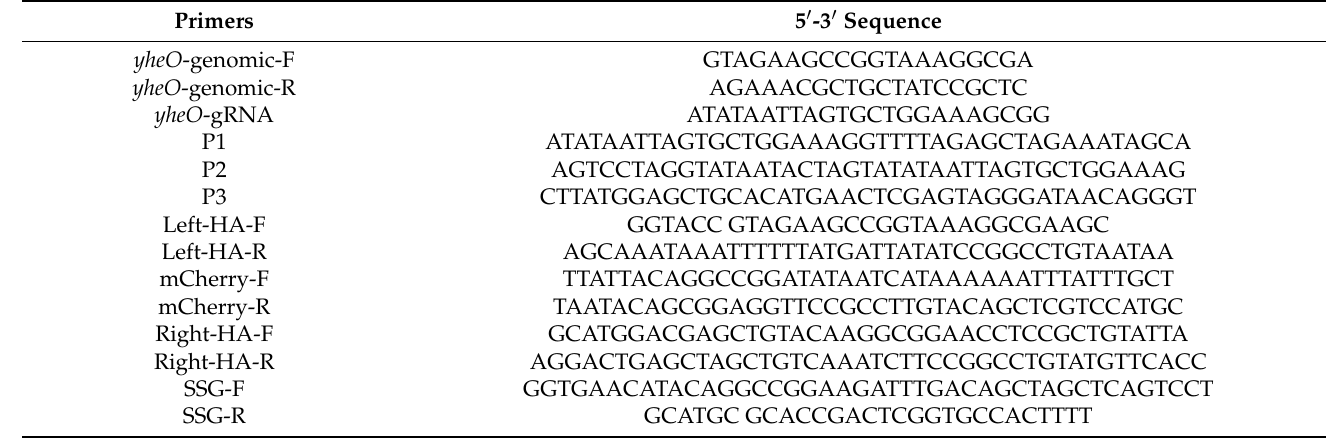
Table 3. Primers used in the construction of mCherry-labeled E. coli